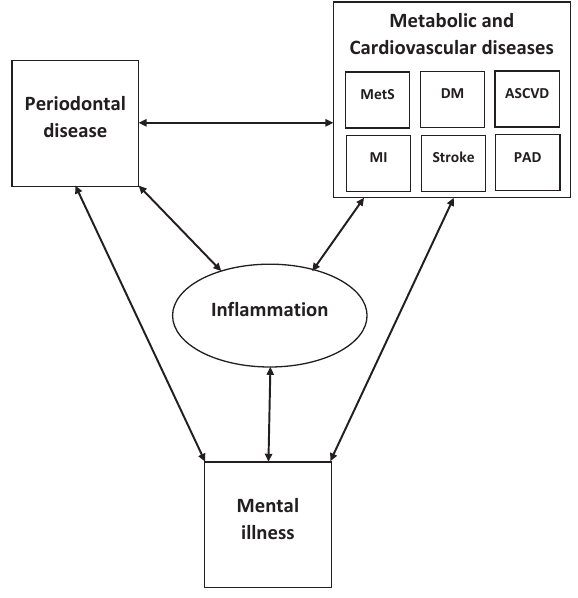
Figure 1: A graphical representation depicting the links between periodontal disease, metabolic diseases, cardiovascular diseases, and mental illness, with inflammation as a common mediator between these disorders. (MetS: Metabolic syndrome; DM: Diabetes mellitus; ASCVD: Atherosclerotic cardiovascular disease; MI: Myocardial infarction; PAD: Peripheral arterial disease)